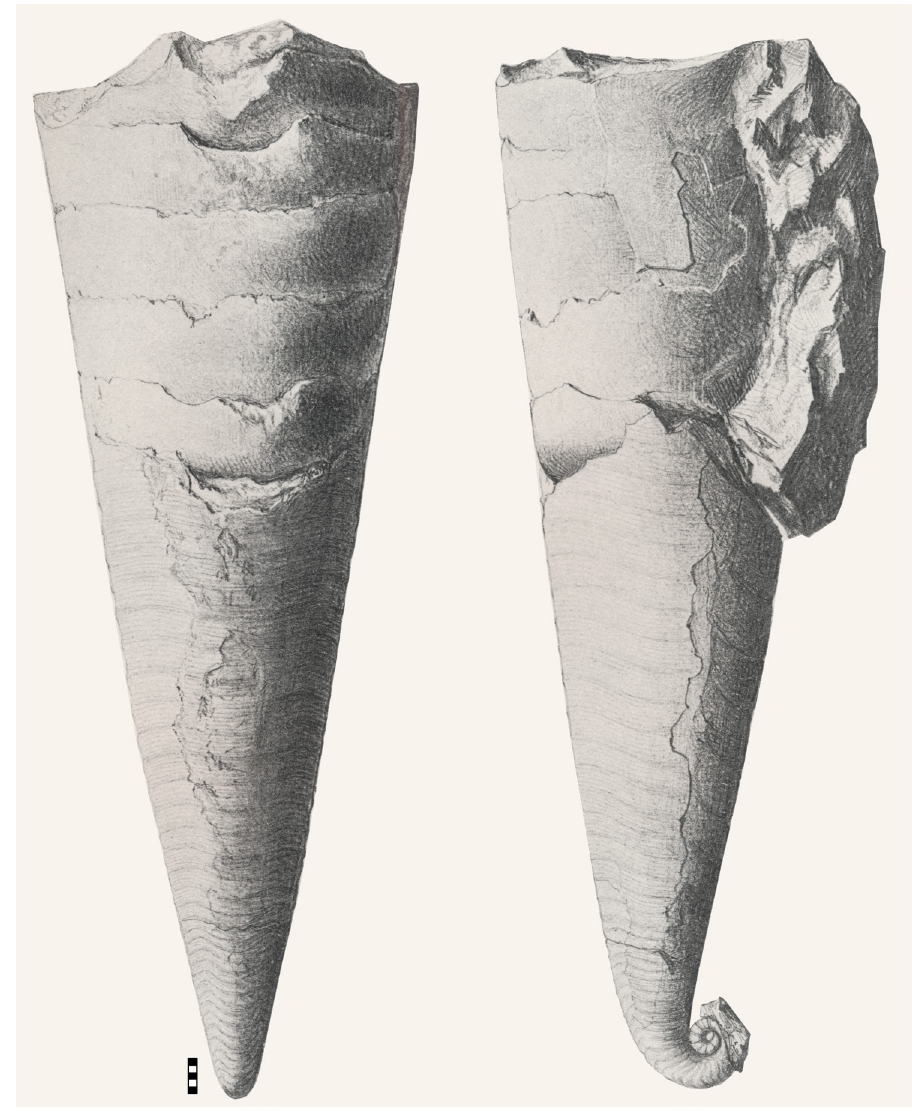
Fig. 20. Ancistroceras barrandei Dewitz, 1880, reproduction of the figure provided by Noetling (1884: pl. 16 Fig. 6–6a). Scale bar units = 1